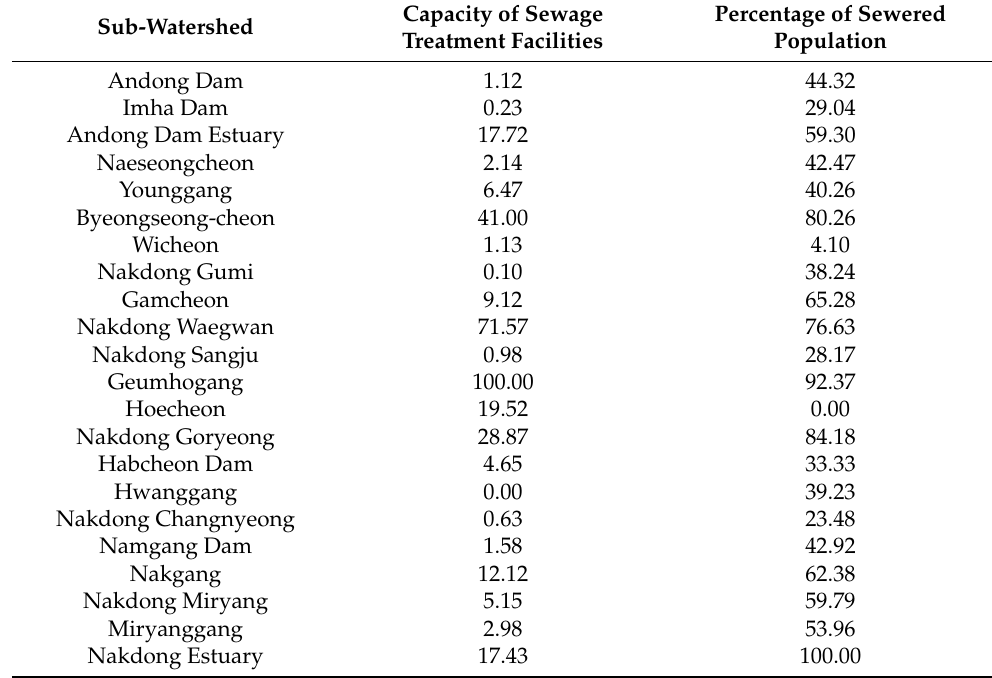
Table 10. Standardized indices of climate change sensitivity in SSP scenarios.